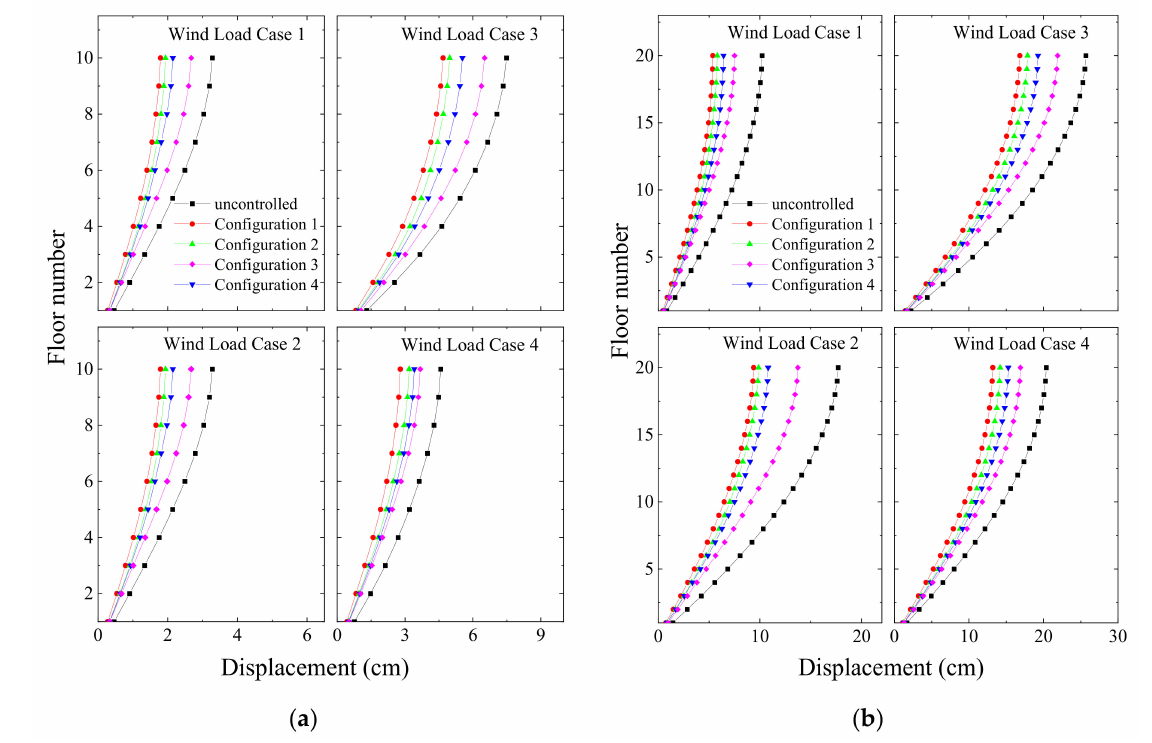
Figure 29. Peak floor displacement in wind excitation of: ( a ) a coupled stiff building and ( b ) a coupled flexible building in different damper configurations under semi-active control of the MR damper.